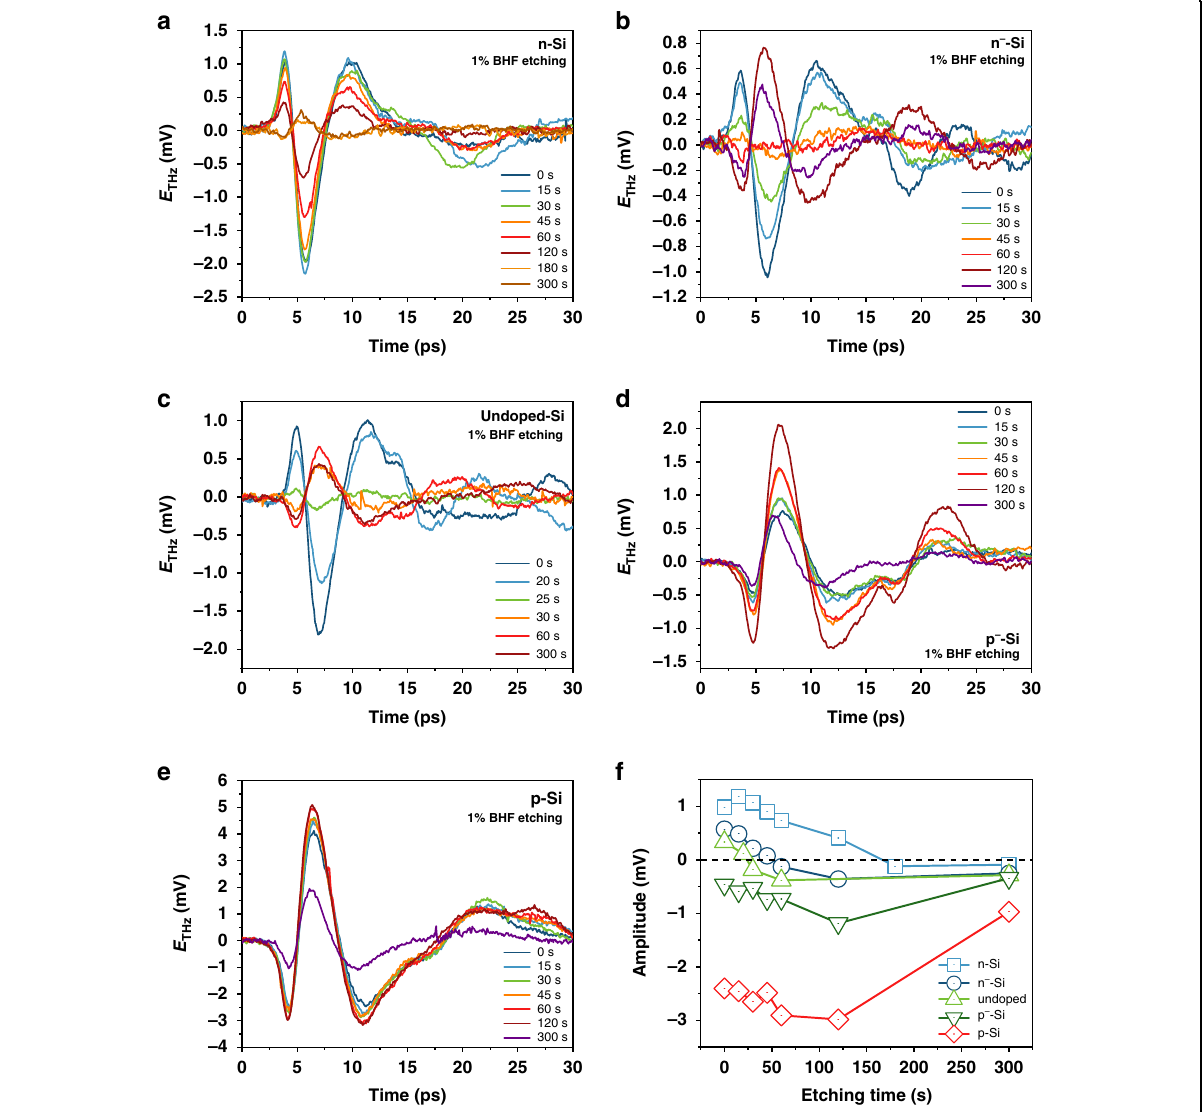
Fig. 3 THz emission variation with different BHF etching times. THz emission spectra from Si wafers with different etching times by using a 1% dilute BHF solution: ( a ) n-type Si, ( b ) n − -type Si, ( c ) undoped Si, ( d ) p − -type Si, and ( e ) p-type Si. f Variation of THz emission amplitude (the fi rst peak) with the increase of etching